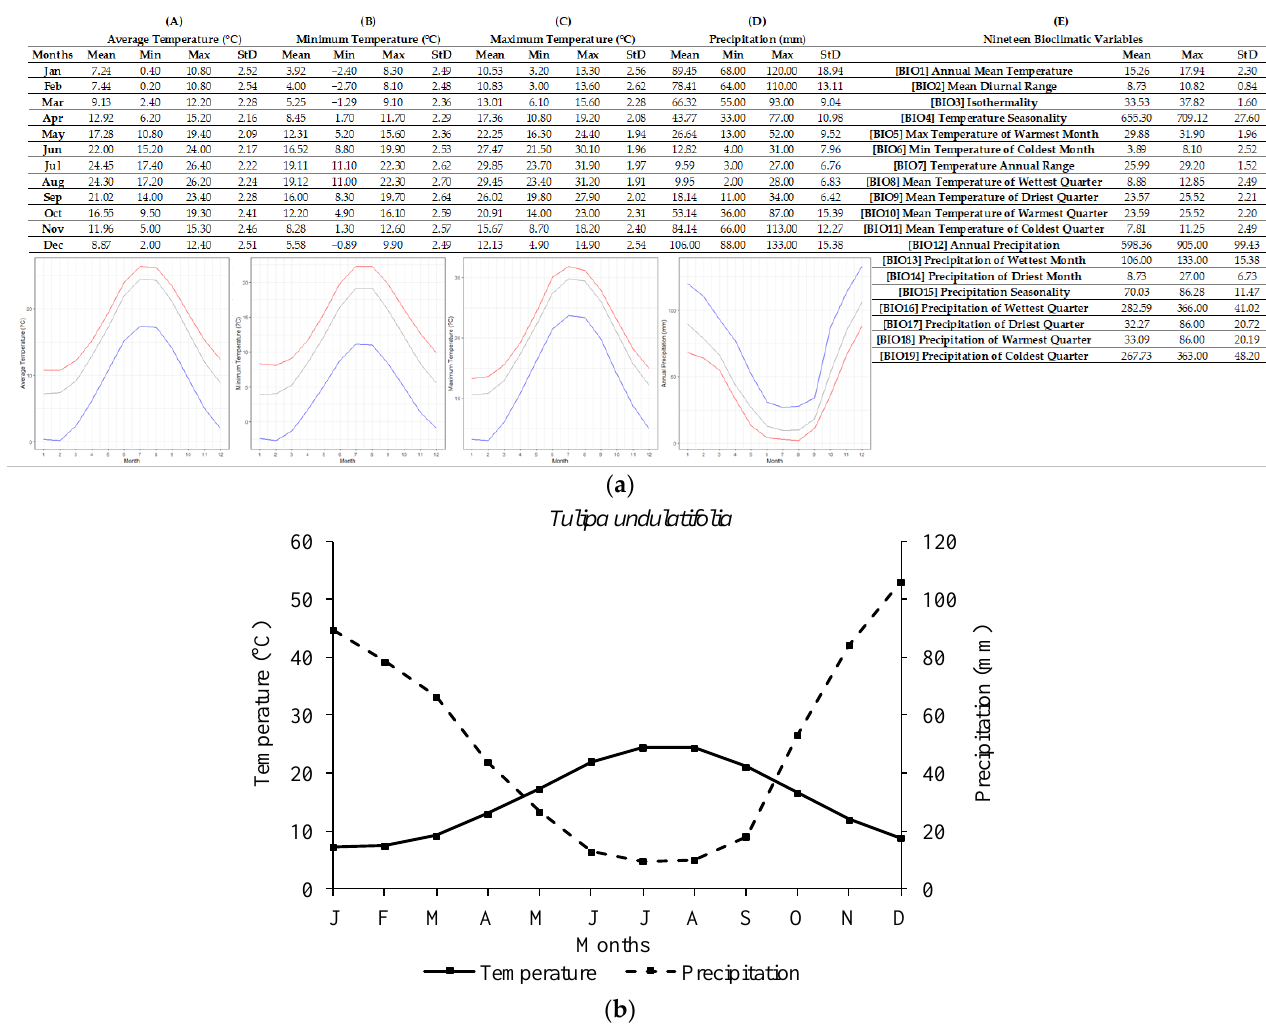
Figure 6. R-derived ecological profile ( a ) and Walter–Lieth climate diagram ( b ) of Tulipa undulatifolia based on 22 Greek localities of high accuracy known to date (N = 22). For ( A – E ), minimum, maximum, and average values and standard deviations are represented in different columns. Line graphs ( A – C ) illustrate the minimum (blue), the maximum (red), and the mean (grey) monthly temperature ( ◦ C) and the line graph ( D ) illustrates the minimum (red), maximum (blue), and mean (grey) monthly precipitation (mm). ( A ) shows the minimum temperature in each month ( ◦ C), ( B ) shows the maximum temperature in each month ( ◦ C), ( C ) shows the average temperatures per month ( ◦ C), ( D ) shows the precipitation in each month (mm), and ( E ) shows the values for each of the 19 bioclimatic